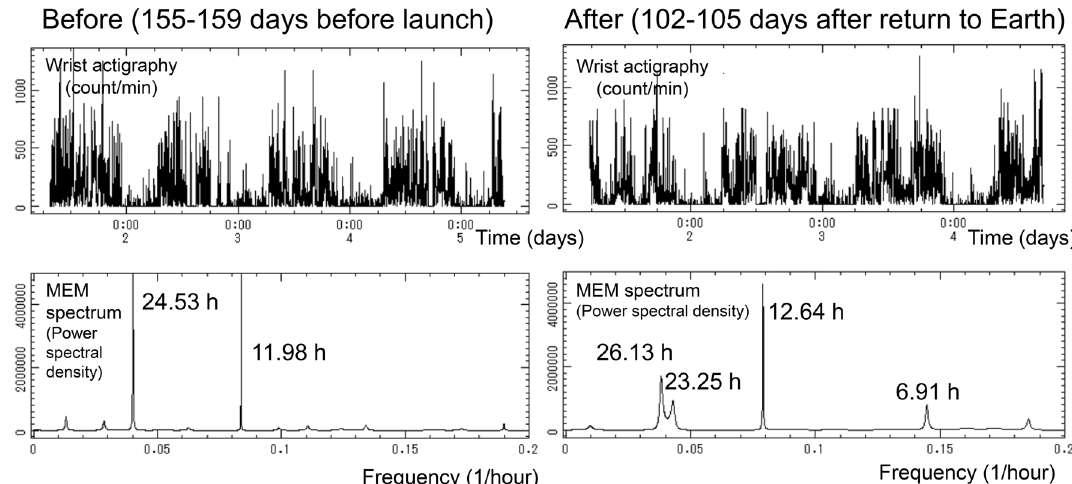
Figure 3. MEM spectral analysis of actigraphy records spanning about 84 h before (left) and after (right) the mission in space. Left: Circadian rhythm with an estimated period of 24.53 h is detected together with a circasemidian component with an estimated period of 11.98 h. Right: Decreased circadian prominence along with split of circadian rhythm into two components with estimated periods of 26.13 and 23.25 h, suggesting the occurrence of social jetlag after return to